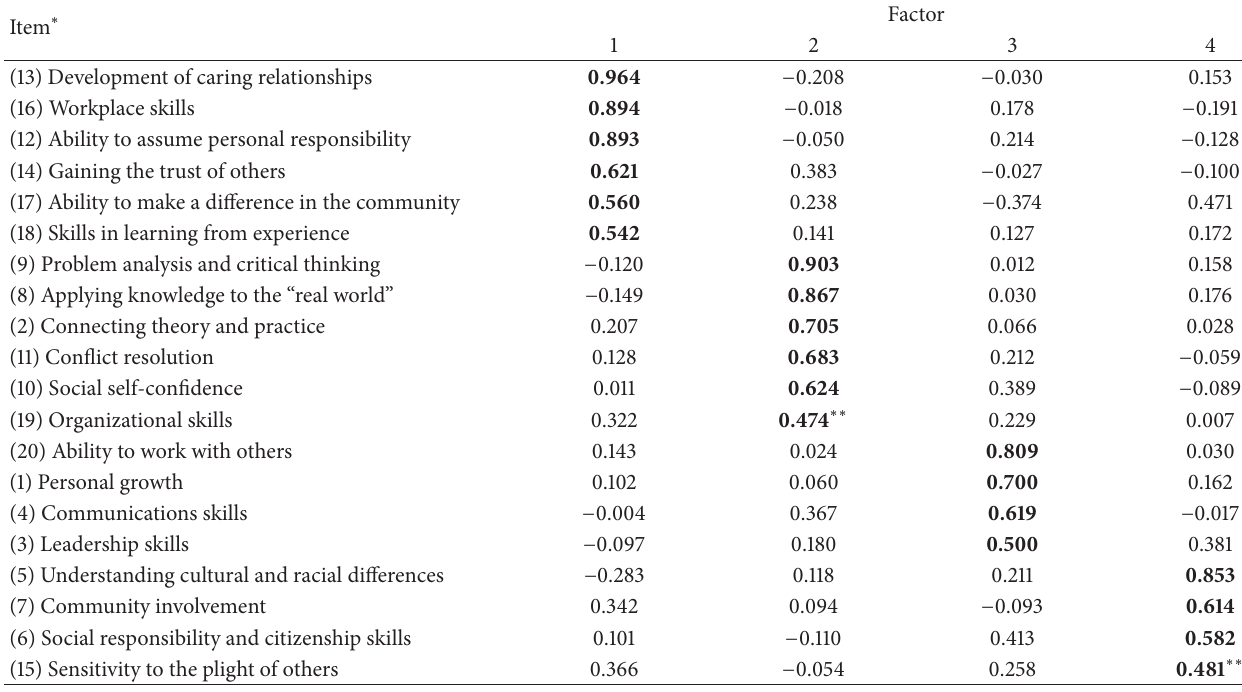
Table 2: The rotated factor matrix of service learning benefits.